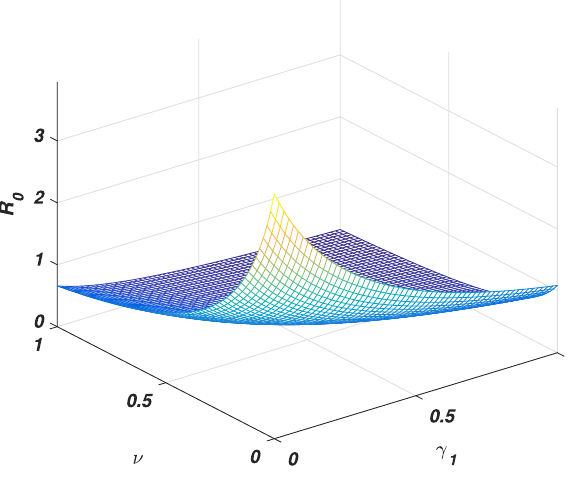
Figure 4. The variation of the basic reproductive number for the parameters γ 1 and v